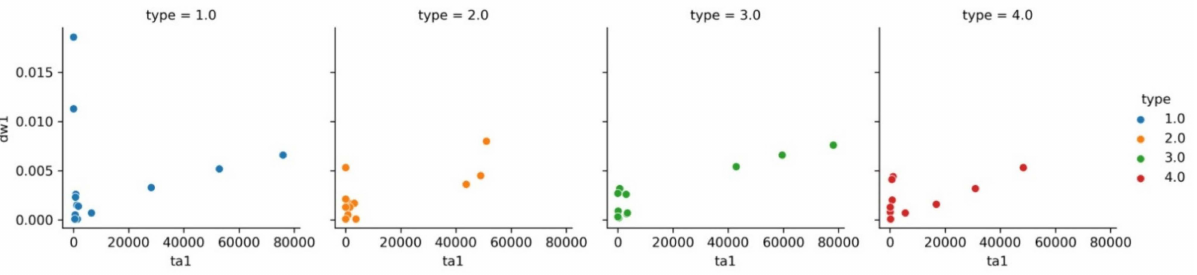
Figure 3. Dependence of dw1 on ta1 separately for each class.